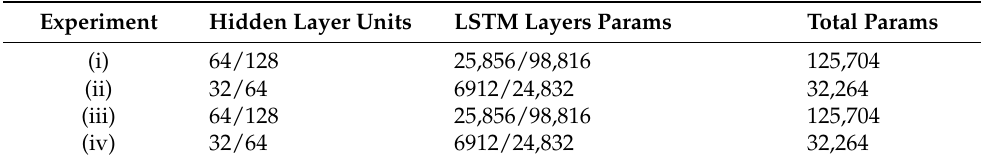
Table 8. Parameter of LSTM networks in experiments